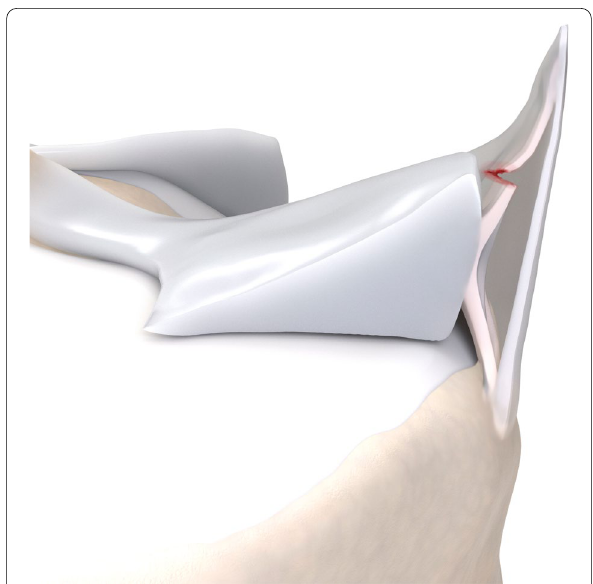
Fig. 2 Type 1 ramp lesion illustration, defined as meniscocapsular ligament tear